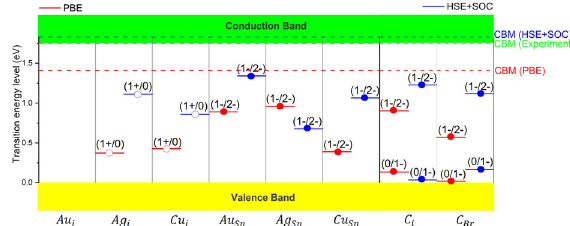
Fig. 7 Impurity charge transition levels. The calculated transition energy levels within the bandgap for the major electrode impurities in α -CsSnBr 3 . The empty circles denote donors, and fi lled circles for